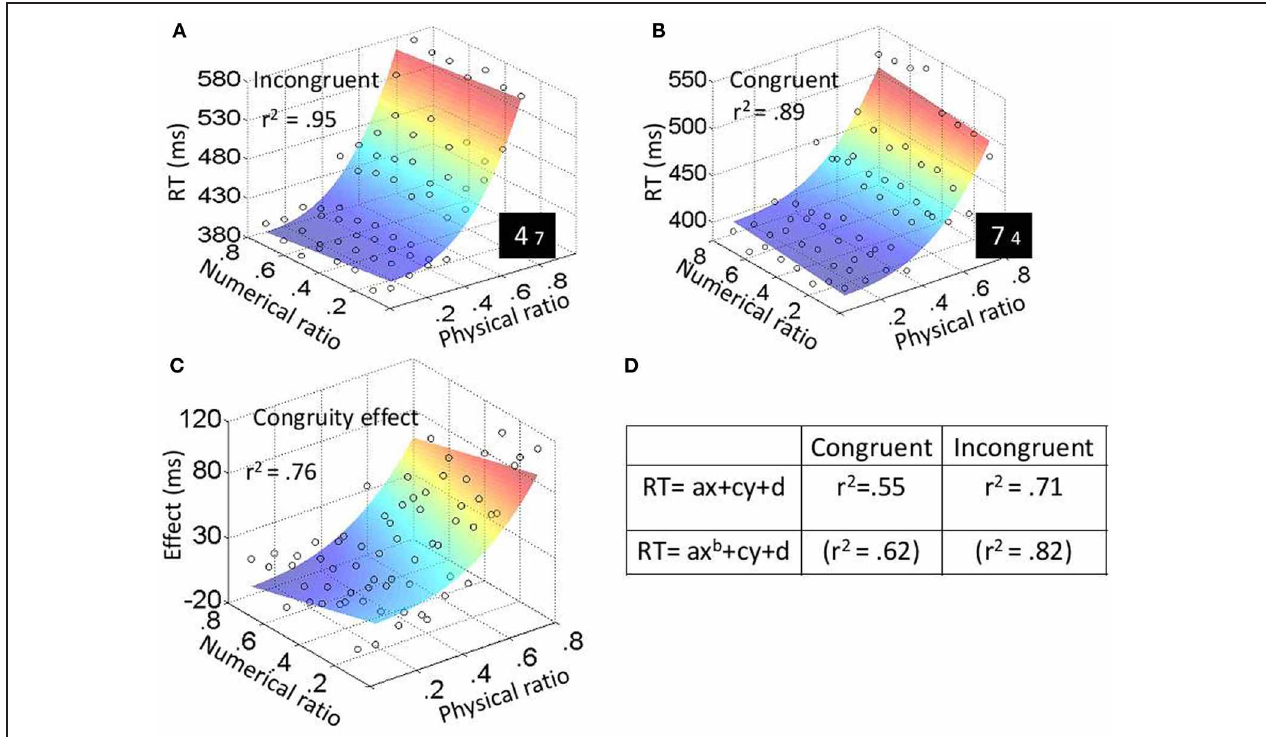
highest RTs. Fit values for plots (A) , (B) , and (C) are higher than the average of the fits based on individual participants. (D) Fits ( r 2 ) when fitting the plots of the different conditions to function (1) or function